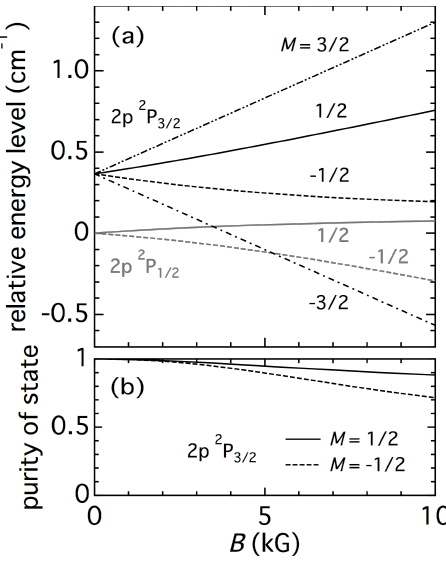
Figure 6. ( a ) energy level shifts of the magnetic sublevels in the hydrogen 2p 2 P 1/2 and 2p 2 P 3/2 states due to the Zeeman effect and ( b ) purity of the state for the M = 1/2 and M = − 1/2 levels in the 2p 2 P 3/2